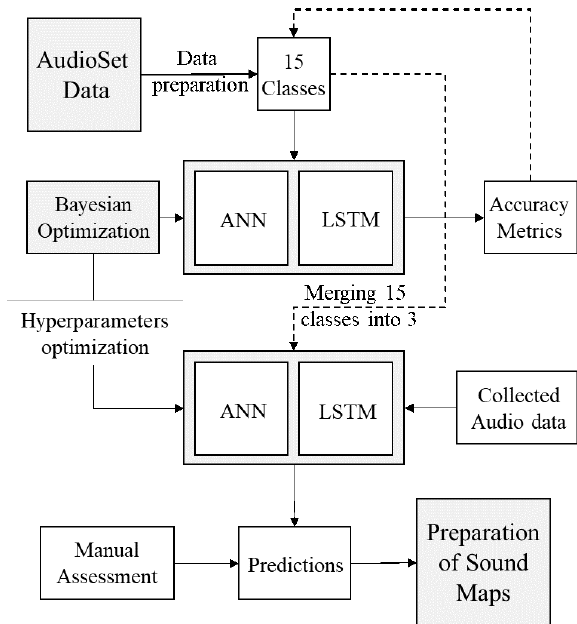
Figure 1: Flowchart showing the methodology of the